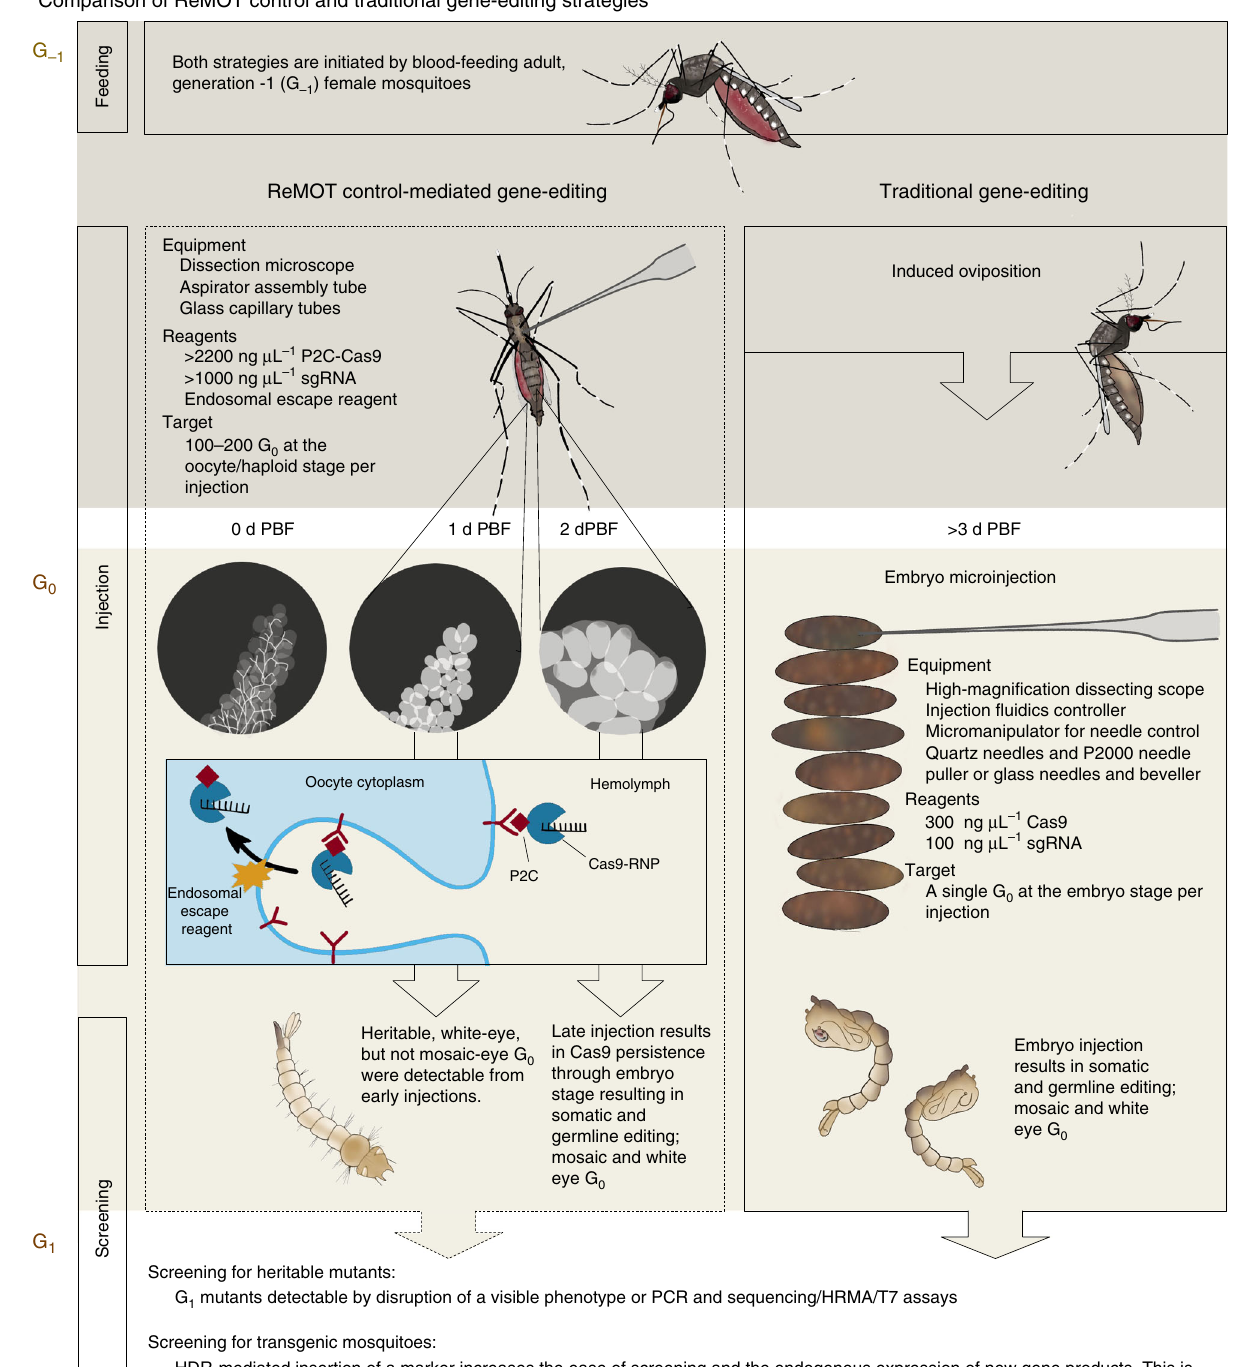
Fig. 5 Schematic description and model of ReMOT Control vs embryo injection for Cas9-mediated gene targeting. ReMOT Control-mediated and traditional gene-editing strategies are compared in terms of methods (injection stage and timing, equipment, reagents, screening). Generation designations (Gx) are indicated in brown letters at the top left of each panel. A schematic model of the uptake of P2C-Cas9 RNP into the mosquito oocyte is illustrated in the G 0 , ReMOT Control panel. PBF post-blood feeding, RNP ribonucleoprotein, sgRNA single guide RNA, HRMA high-resolution melting assay, HDR homology-directed